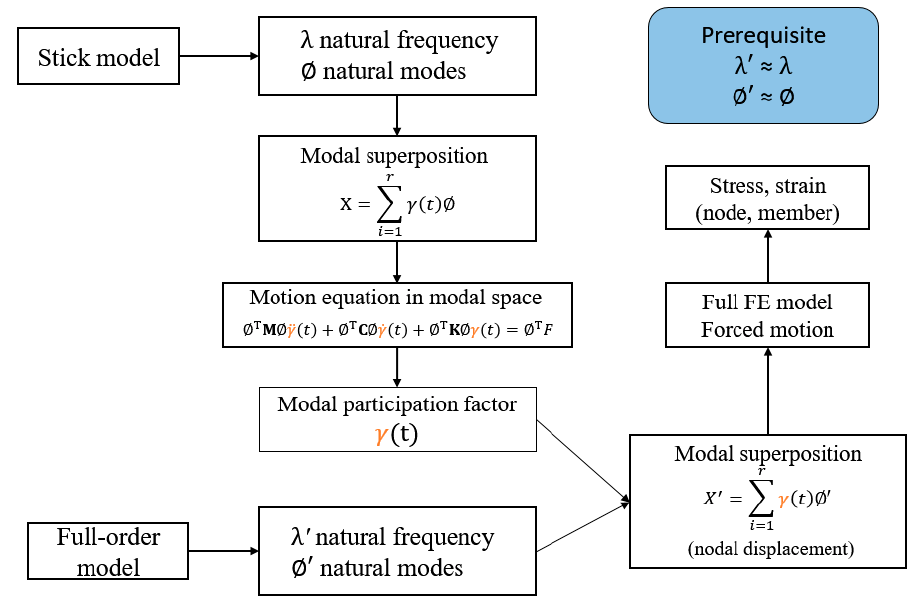
Figure 2. Workflow of the proposed framework.